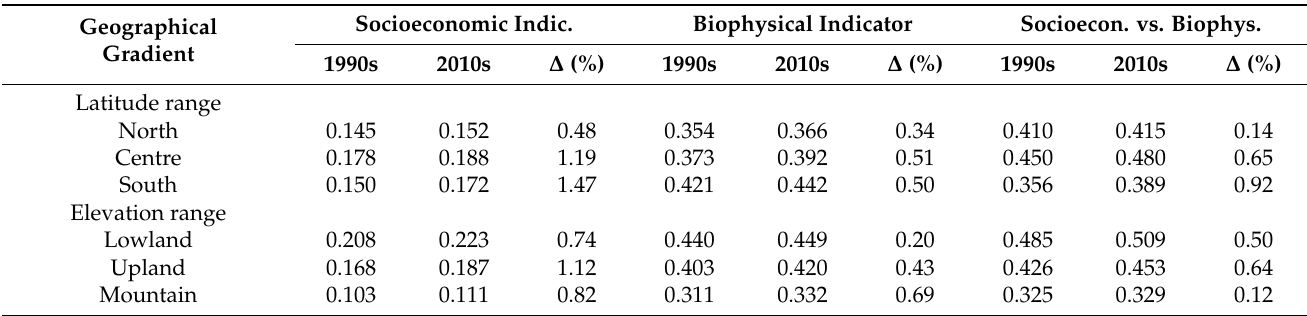
Table 2. Average score of socioeconomic and biophysical dimensions of land sensitivity to degradation in Italy by macro- region and time point, and the absolute ratio of socioeconomic to biophysical indicator’s score. Socioeconomic Indic. Biophysical Indicator Socioecon. vs. Geographical Gradient